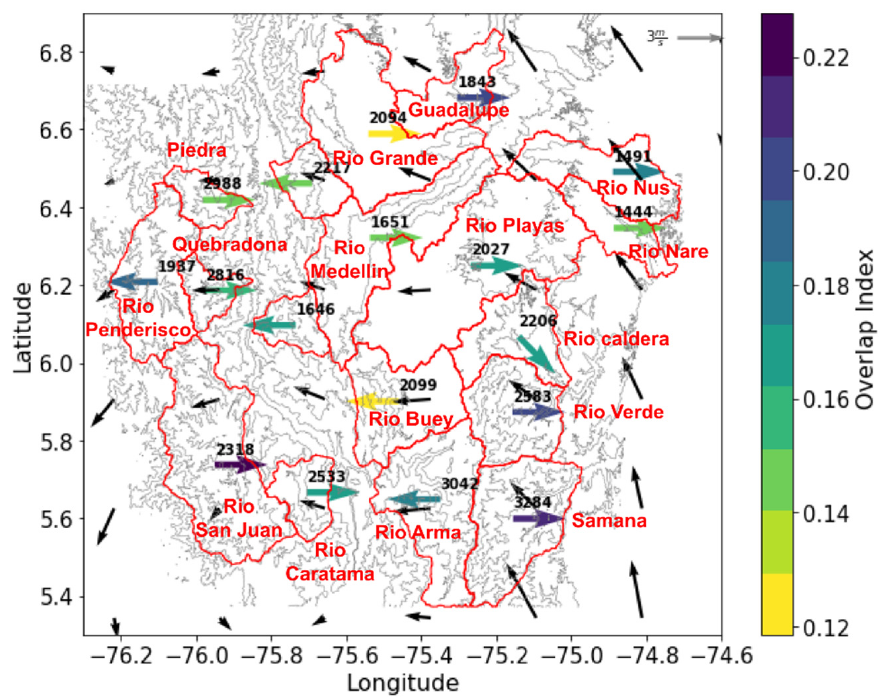
Figure 10. Spatial distribution of the overlap index. The bold arrows represent the aspect of the watersheds, while their color corresponds to the overlap index. Black arrows represent the ERA-5 wind speed and direction. The red and black lines are the watershed boundaries and topography (500 m). The numbers represent the elevation gradient.